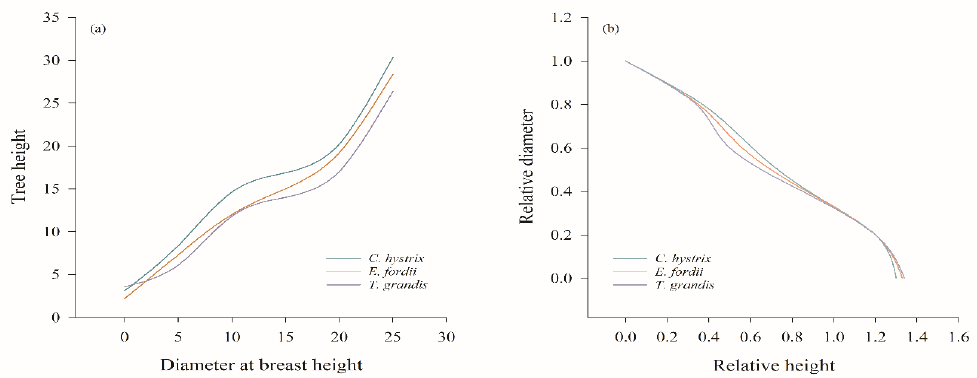
Figure 3. The relationship with Diameter at breast height and height ( a ), and relative and relative diameter ( b ) of Erythrophleum fordii , Castanopsis hystrix and Tectona grandis , respectively. Table 4. The two-way merchantable volume table of Erythrophleum fordii by model (2). Diameter Class